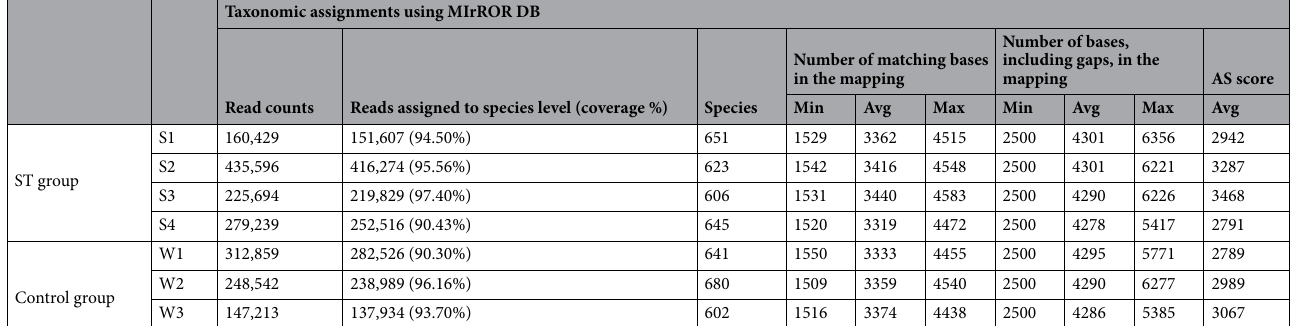
Taxonomic assignments using MIrROR